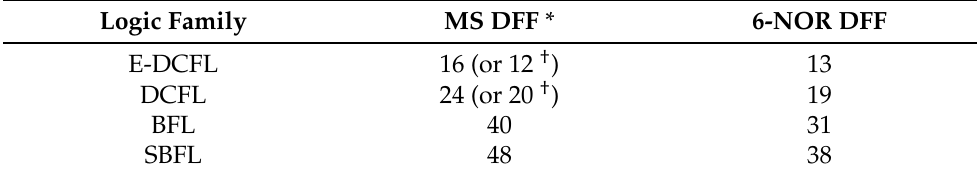
Table 3. D flip-flop transistor count for the different logic families of Figure 3: comparison between the MS DFF and the 6-NOR/6-NAND